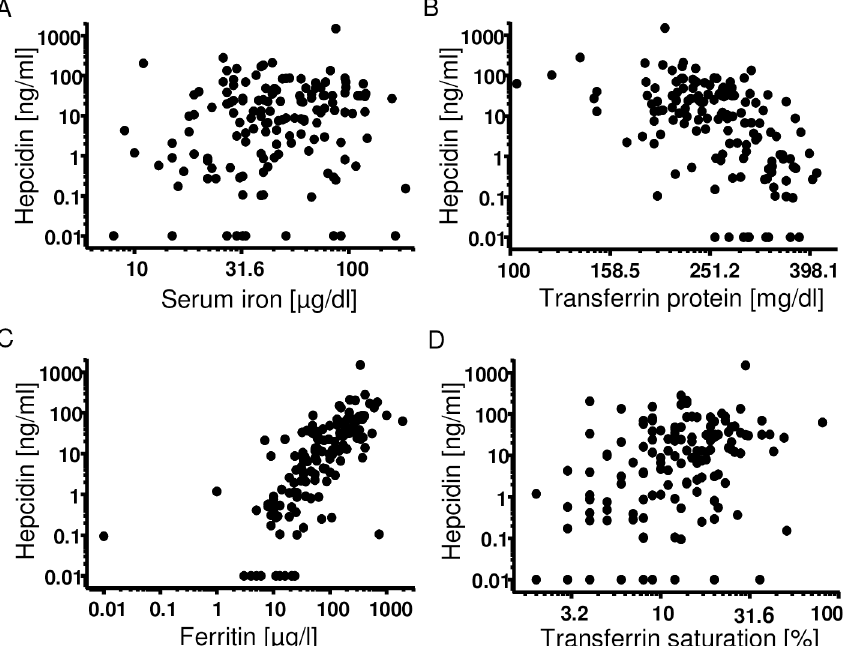
Fig 1. Correlation of serum hepcidin levels with parameters of the iron status. Serum hepcidin levels of the three patient groups of non-anemic controls, anemic patients treated with IV iron and anemic patients without IV iron treatment, were correlated to the iron parameters. The x- and y-scales are depicted logarithmic (log10). Values of “0” were replaced with 0.01 in order to depict them in the logarithmic graph. Serum hepcidin levels correlated with (A) serum iron levels (n = 146 XY-pairs (n = 9 non-anemics, n = 58 anemics without IV iron, n = 79 anemics plus IV iron); r = 0.19; Spearman (cid:3) p = 0,02), (B) transferrin protein levels (n = 143 XY-pairs (n = 6 non-anemics, n = 58 anemics without IV iron, n = 79 anemics plus IV iron); r = -0,55; Spearman (cid:3) p < 0.0001), (C) ferritin levels (n = 143 XY-pairs (n = 6 non-anemics, n = 58 anemics without IV iron, n = 79 anemics plus IV iron); r = 0,75 Spearman (cid:3) p < 0.0001) and (D) transferrin saturation (n = 142 XY-pairs (n = 5 non-anemics, n = 58 anemics without IV iron, n = 79 anemics plus IV iron); r = 0.37; Spearman (cid:3) p < 0.0001).